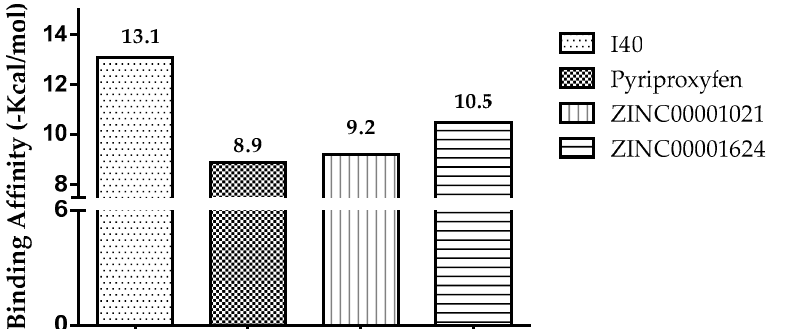
Figure 4. Results of binding affinity of the compounds with insect acetylcholinesterase ( Drosophila melanogaster organism), Protein Data Bank (PDB) ID 1QON.